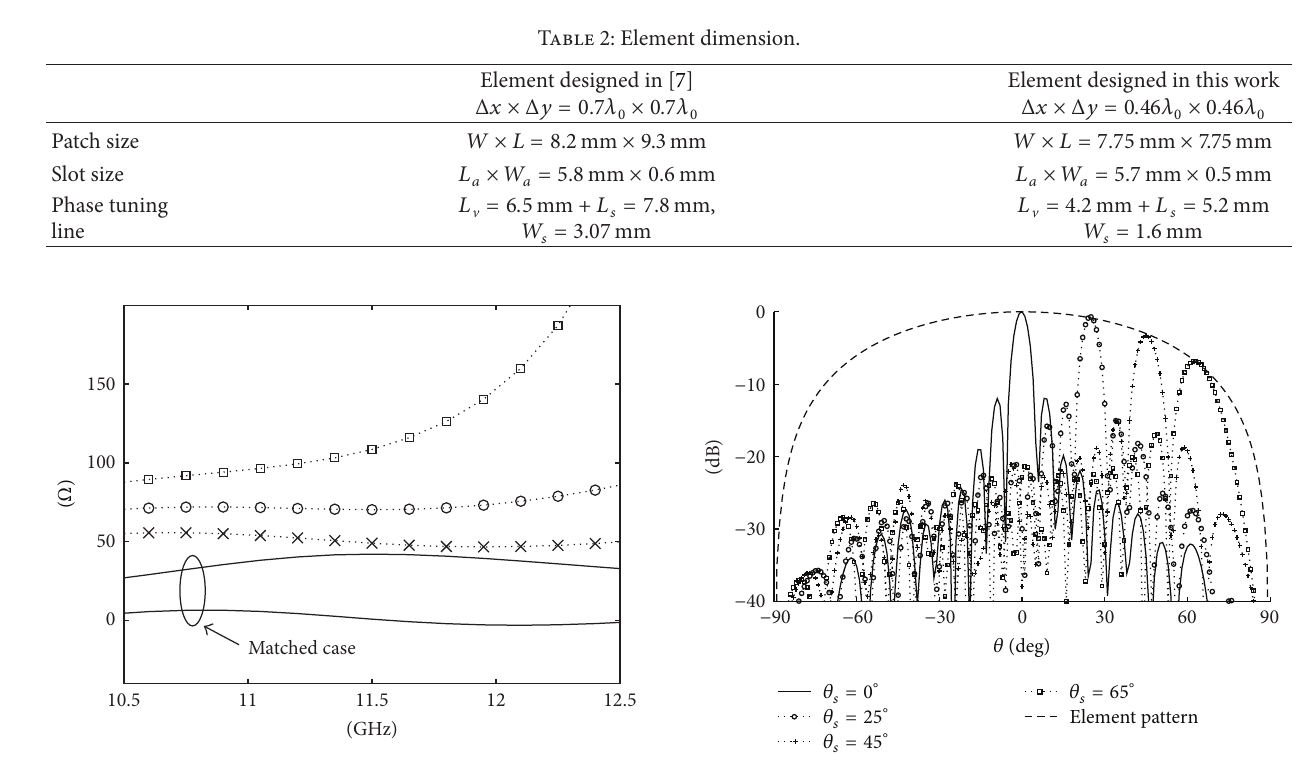
Figure 8: Computed radiation patterns for different configurations of the varactors capacitance